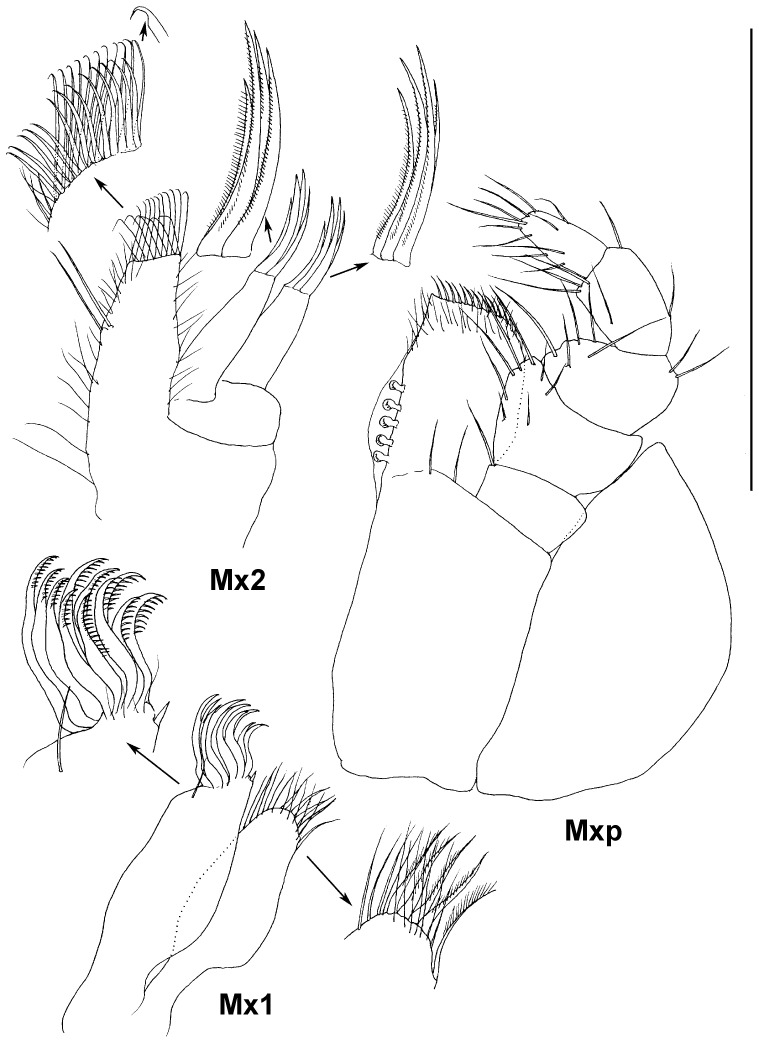
Paratype ZMH K-44090, male, mouth parts, scale – 0.5 mm.